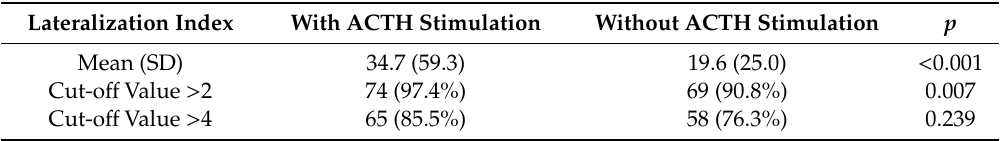
Table 3. Lateralization index results in 76 patients with and without adrenocorticotropic hormone (ACTH) stimulation.